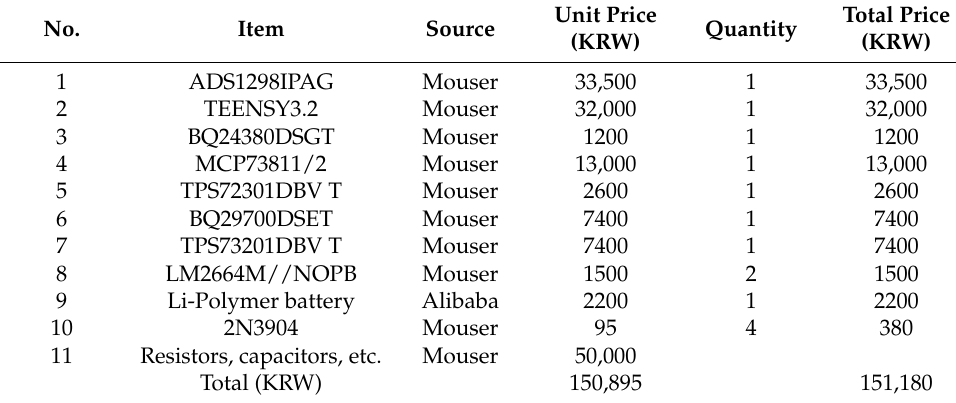
Figure 7. Graphical User Interface used to store and display EEG and fNIRS data. Table 1. EEG/fNIRS system